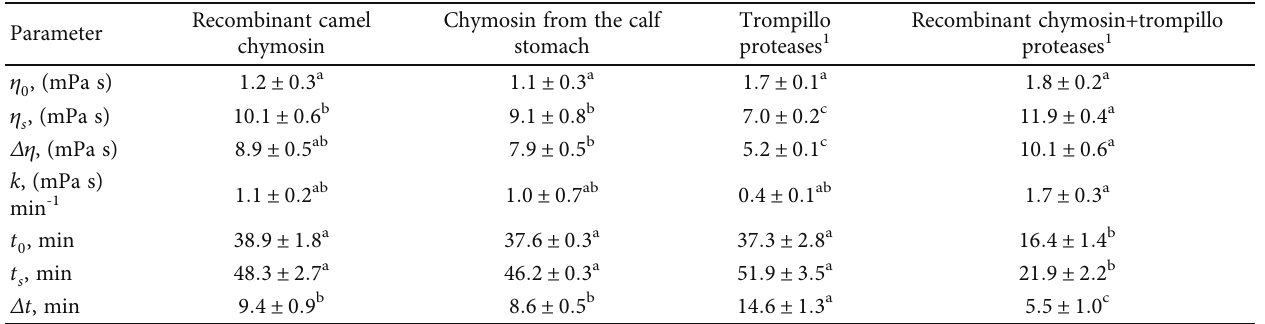
Table 3: Rheological behavior of milk clotted with di ff erent proteases at 30 °